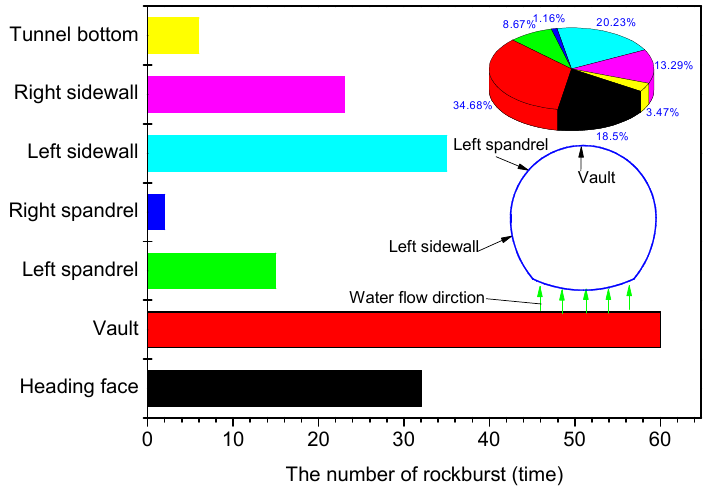
Figure 11. Field statistics of rockburst in diversion tunnel 2.